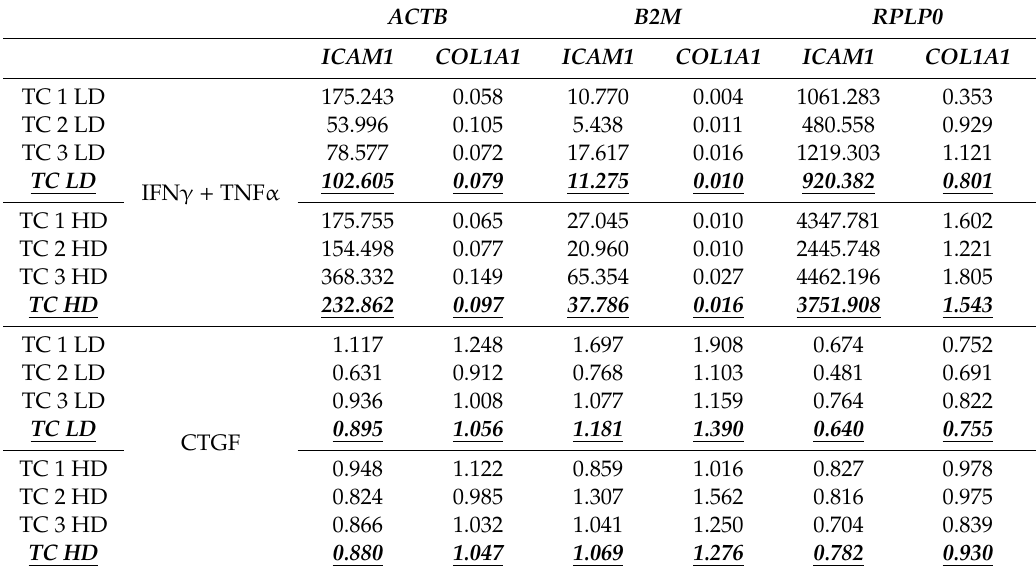
Figure 4. ICAM1 ( A ) and COL1A1 ( B ) modulation under IFN γ + TNF α or connective tissue growth factor (CTGF) supplementation is dependent on the selected RGs. Increase in ICAM1 and decrease in COL1A1 expression with respect to untreated cells are significantly di ff erent depending on which RG ( B2M or RPLP0 ) is used. Values are expressed as fold-change mean ± SEM, n = 3 independent cell isolates; ns: non-significant, * for p -value < 0.05, ** for p -value < 0.01, *** for p -value < 0.001. Table 3. ICAM1 and COL1A1 modulation in single samples and their general